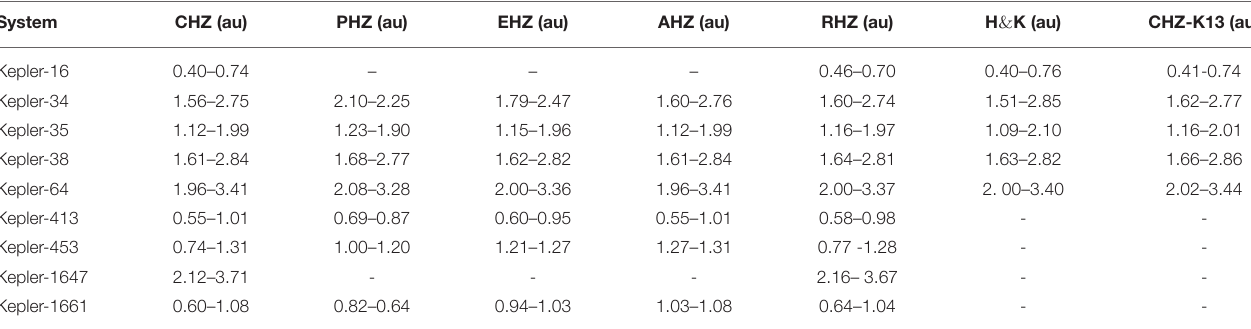
TABLE 3 | Habitable zone limits for Kepler-16, Kepler-34, Kepler-35, Kepler-38, Kepler-64, Kepler-413, Kepler-453, Kepler-1647, and Kepler-1661.